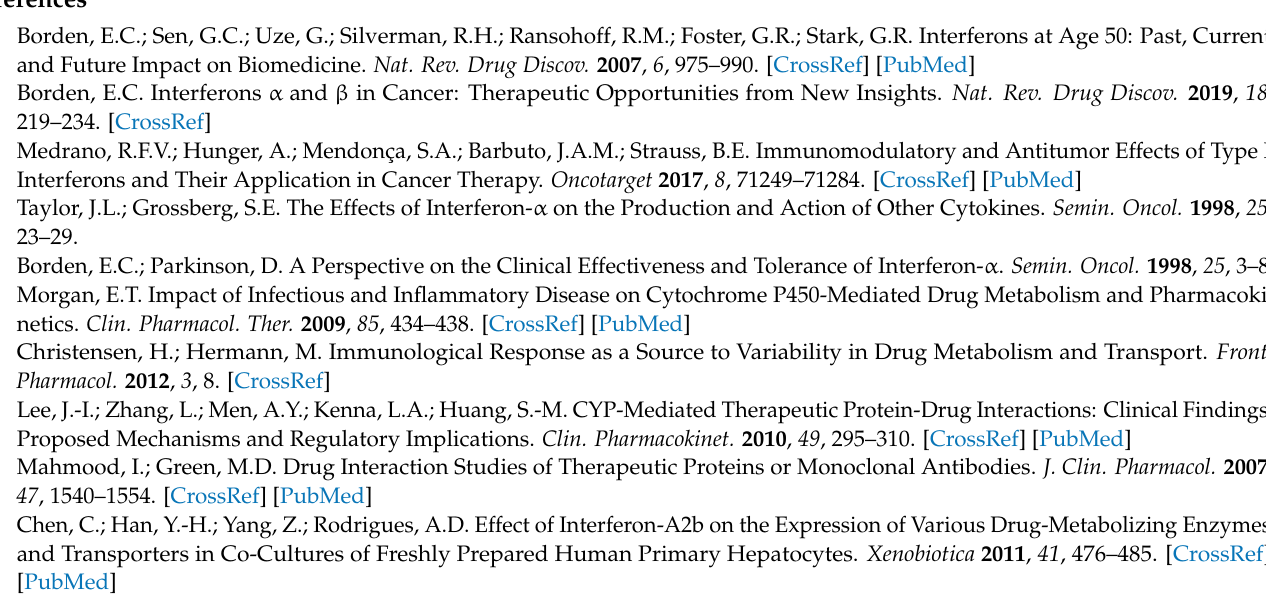
Table S1: primers used for